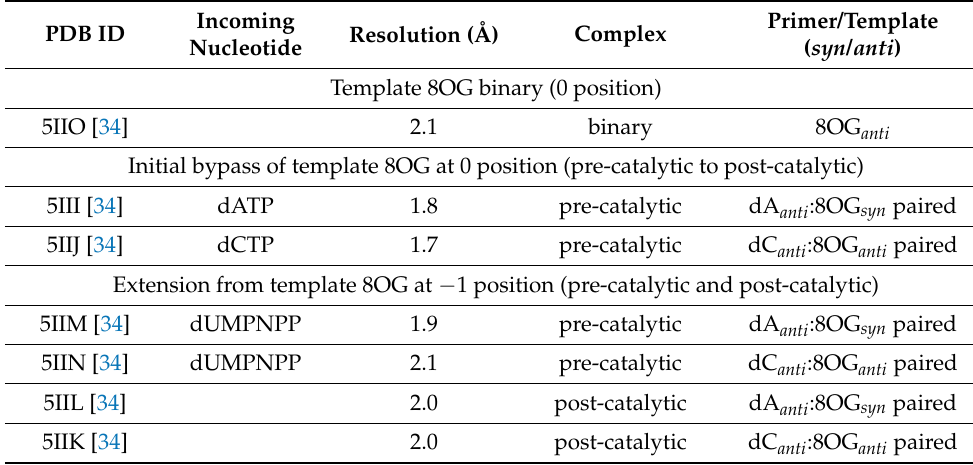
Table 2. X-ray crystal structures of template 8OG bypass and extension by Pol λ